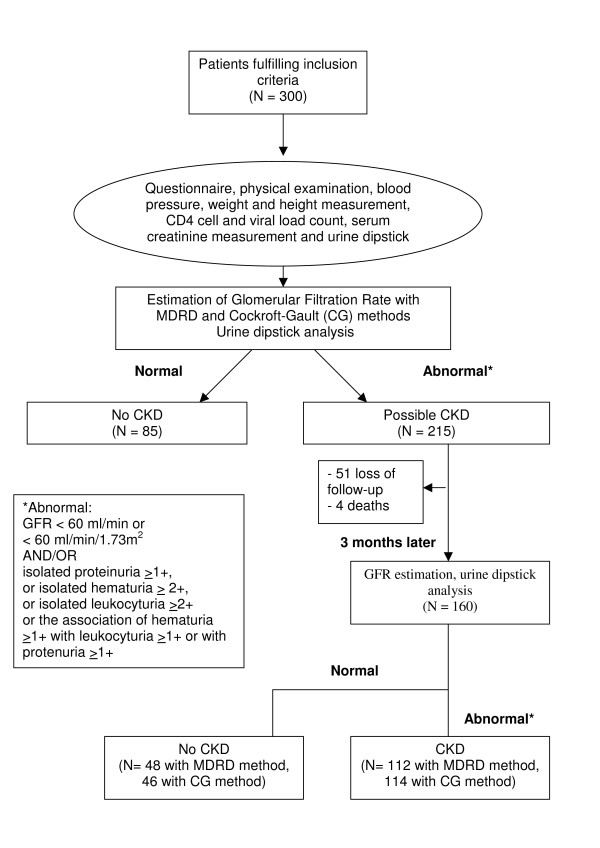
flowchart of included patients.